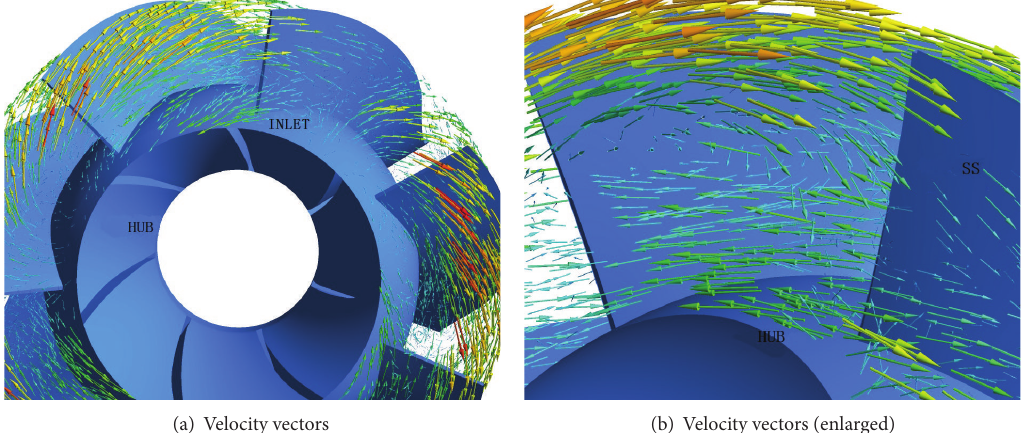
Figure 18: Relative velocity vectors near the LE of diffuser at 0.65 𝑄